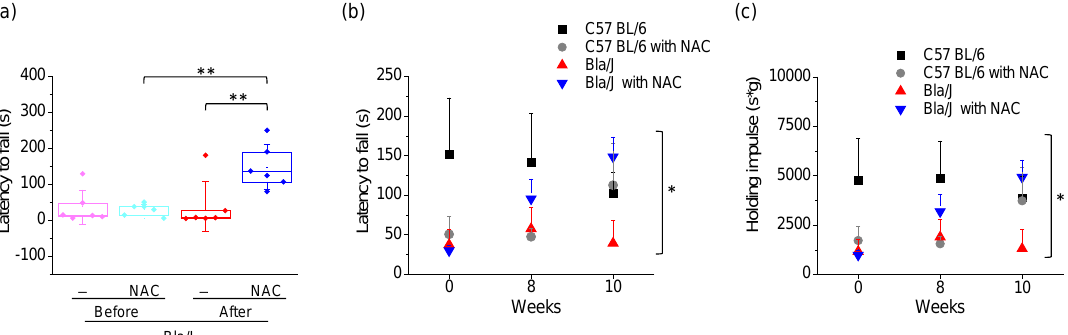
Figure 4. Effect of NAC on grip strength in dysferlin-deficient Bla/J mice. Grip strength was measured using the Kondziela’s inverted screen test. Panel ( a ) Boxes indicate 25-75 percentiles of latency to fall, lines within boxes indicate medians, and whiskers indicate SD. Each dot represents an individual sample (six mice per group). ** p < 0.01 (one-way ANOVA followed by Tukey-Kramer multiple comparisons test). Panels ( b , c ) compare latency to fall ( b ) and holding impulse ( c ), calculated by multiplying latency to fall by body mass, in the four groups before NAC supplementation (week 0), at week eight, and at the end of treatment (week 10). Data show mean ± SE. Two-way ANOVA with repeated measures revealed a significant interaction between NAC treatment and measurement time in latency to fall ( F (1.60, 31.95) = 4.53, p = 0.025; η 2 = 0.034) and in holding impulse ( F (1.67, 33.39) = 3.60, p = 0.046, η 2 = 0.059).